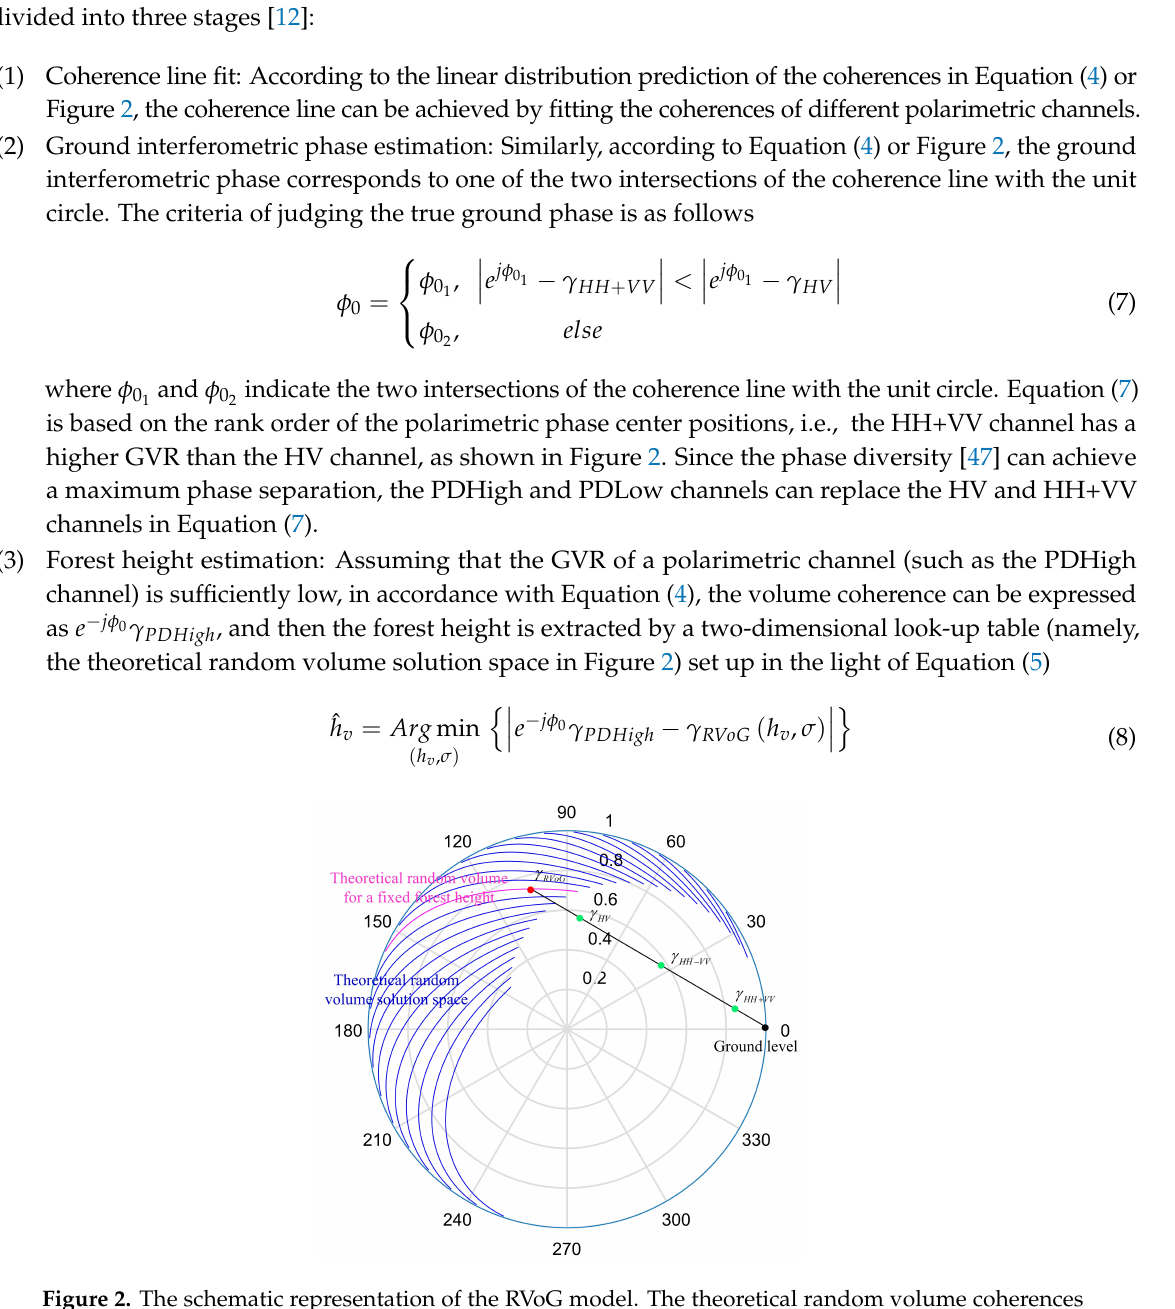
Figure 2. The schematic representation of the RVoG model. The theoretical random volume coherences are exhibited in blue curves for the forest height and mean extinction coefficient ranging, respectively, from 5 to 30 m and 0.02 to 2 dB/m in accordance with Equation (5). Each curve matches a given forest height between which the interval is 1 m. The measured forest height is 19 m, and the homologous volume coherences are indicated by the pink curve. The incidence angle and interferometric vertical wavenumber are set to 0.8 rad and 0.15 rad/m, respectively. The unit circle has been rotated by the ground interferometric phase